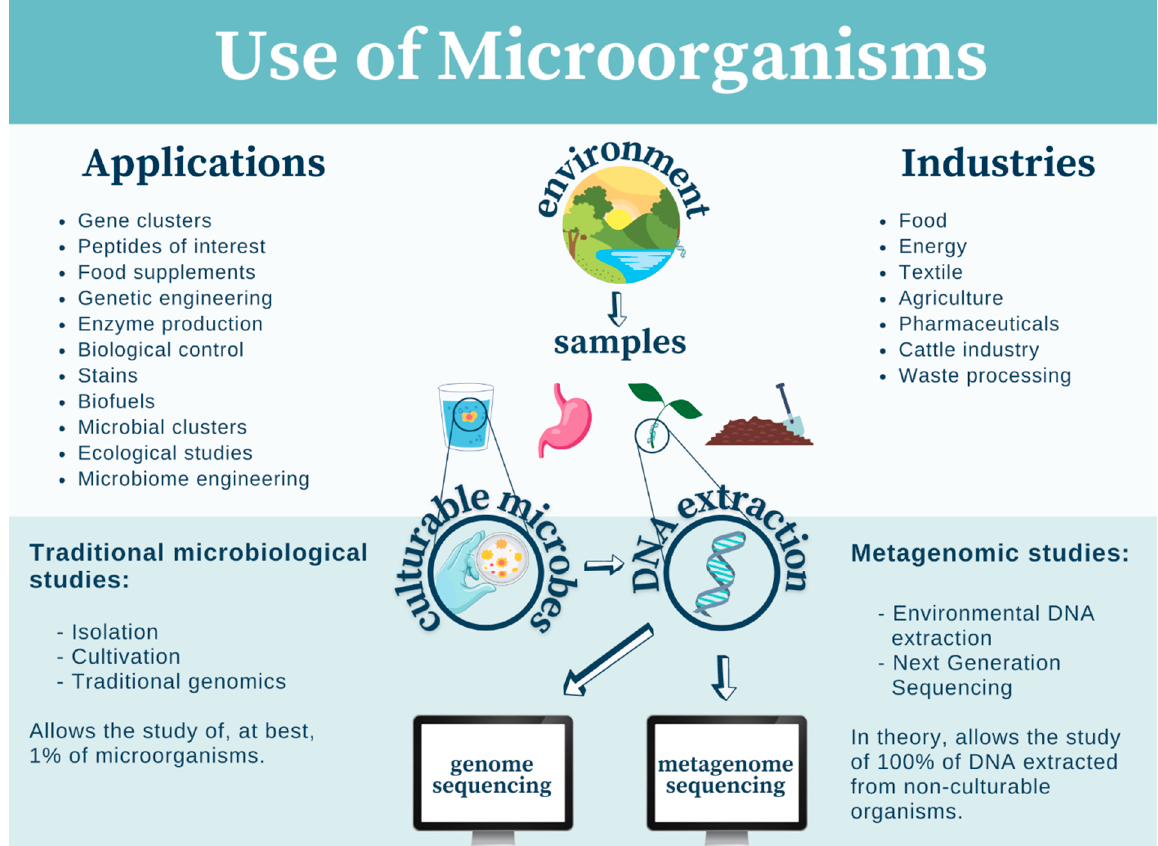
Figure 1. Use and study of microorganisms in modern biotechnology.